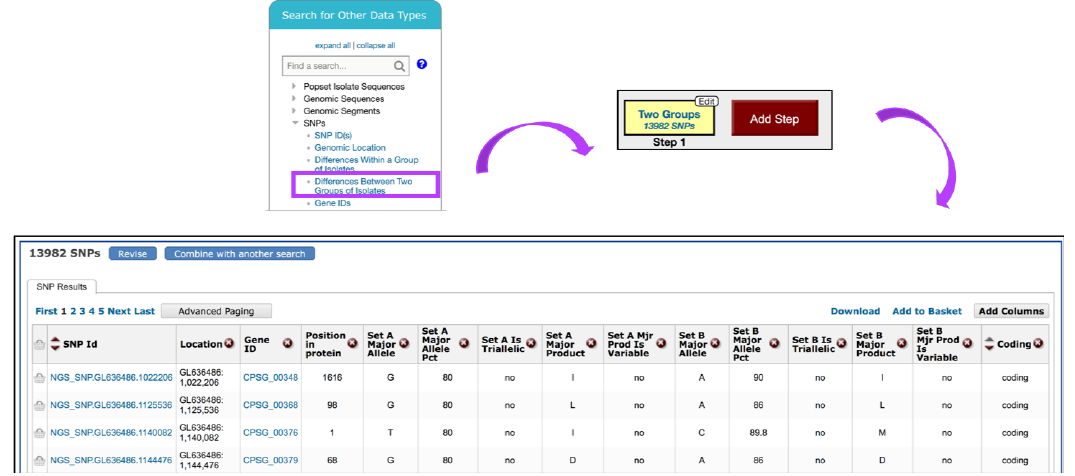
Figure 11. Search for SNPs via the Differences Between Two Groups of Isolates option. SNP search is initiated from the Search for Other Data Types panel on the home page (highlighted in purple). The SNPs results table shown is sorted by Coding column.